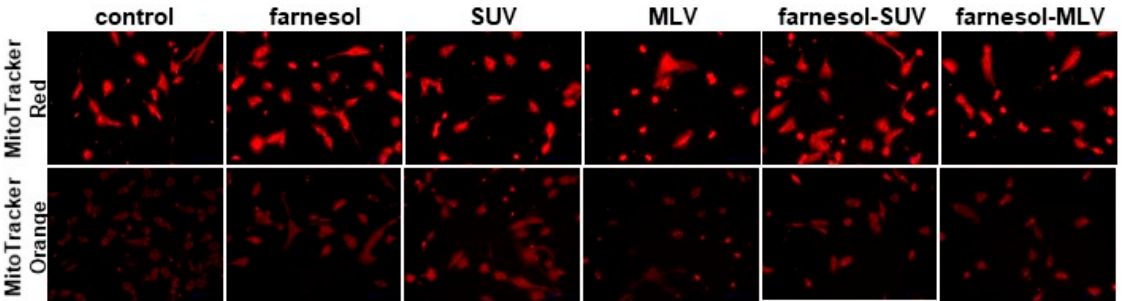
Figure 2. Abundance and oxidative activity of mitochondria in human primary myoblasts. SkMs were left untreated (control) or treated with farnesol, SUV, MLV, farnesol-SUV, or farnesol-MLV, as indicated. After 24 h, SkMs mitochondria were stained using MitoTracker Red (upper panel) or Orange (lower panel). The presented images were captured at the same settings and exposure times and are representative of three independent sets of experiments. High resolution images are provided in the Supplementary Materials, Figure S4.